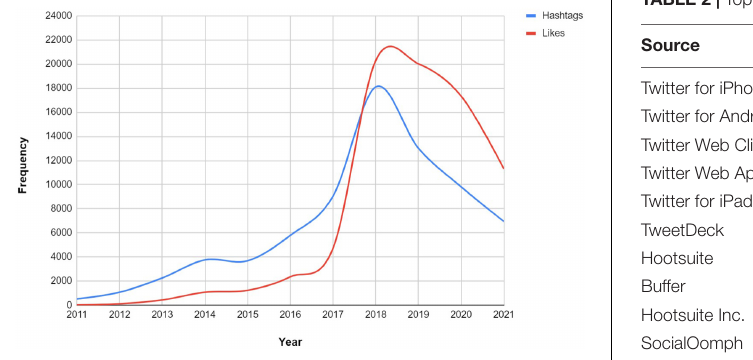
TABLE 2 | Top 10 sources of the